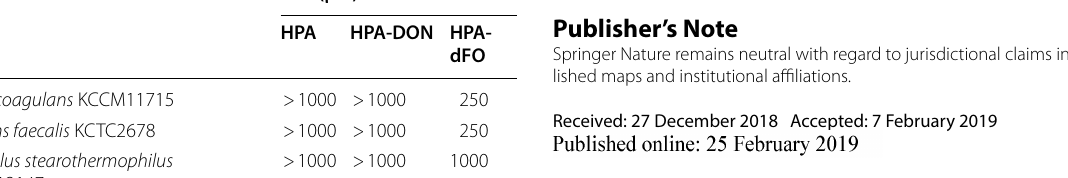
Table 1 Antibacterial activity of HPA-DON and HPA-dFO Bacterial strain MIC